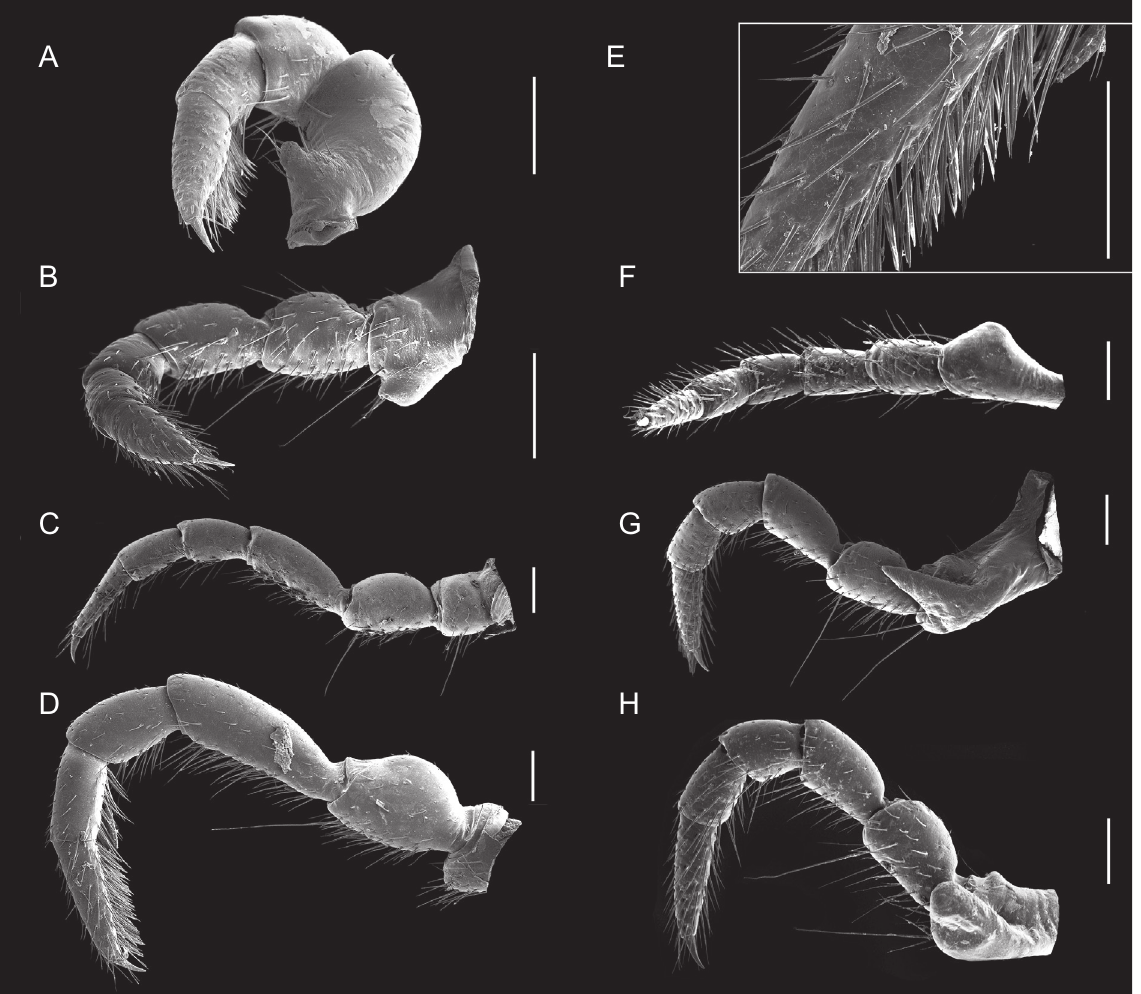
Fig. 5. Legs of Pogonosternum . A , D – E . P. nigrovirgatum (Carl, 1902) (NMV K-12158). A . Male left leg 1, posterior view. B . P. nigrovirgatum (Carl, 1902) (QVMAG 23:46359), male right leg 2, anteroventral view. C . P. jeekeli Decker, sp. nov. (AMS KS106742), male midbody leg, anterior view. D . Male right leg 7, anterior view. E . Male tarsus of right legpair 7, anterior view. F . P. laetificum Jeeker, 1982 (NMV K-9957), female left leg 2, ventral view. G . P. adrianae Jeeker, 1982 (NMV K-12203), female left leg 2, anterior view. H . P. montanum Decker, sp. nov. (AMS KS106907), female left leg 2, anterior view. Scale bars: 0.2